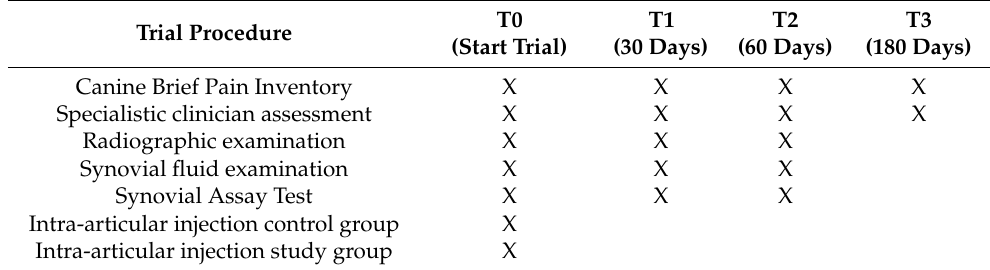
Table 1. Summary and timing of the clinical trial